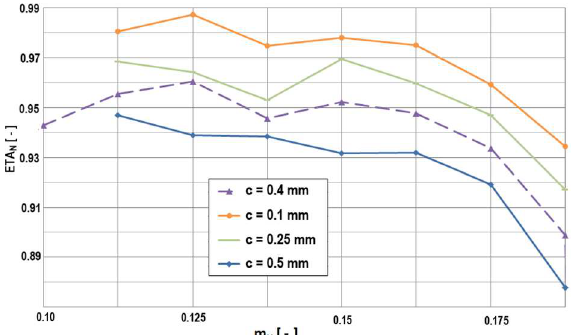
Fig. 13. Influence of the clearance width to the efficiency of the stage .